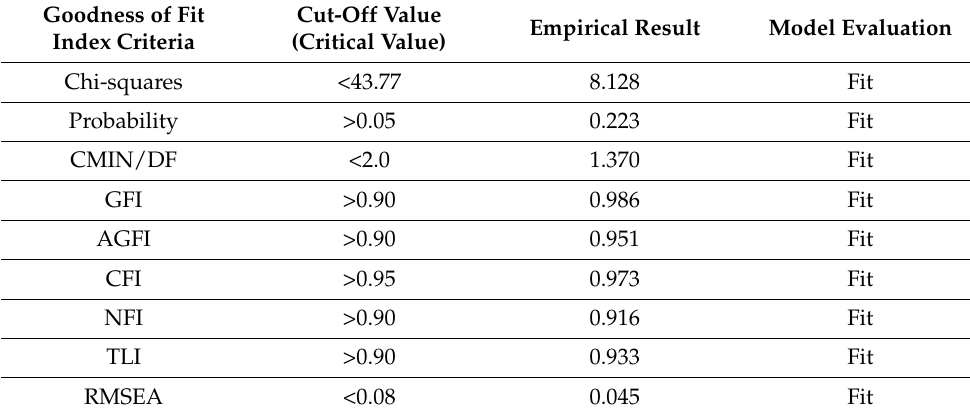
Table 8. Model fit test results/model fit index.